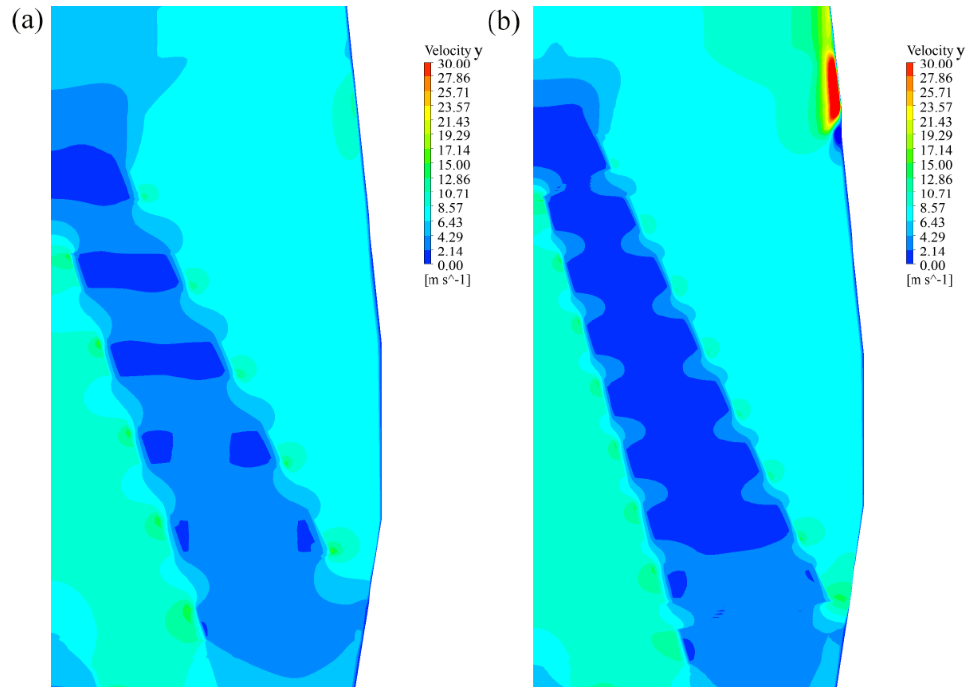
Figure 12. Velocity contours of y-direction in cohesive zone ( γ = 60 ◦ ): ( a ) R = 50%, n = 6, ( b ) R = 90%, n = 9.